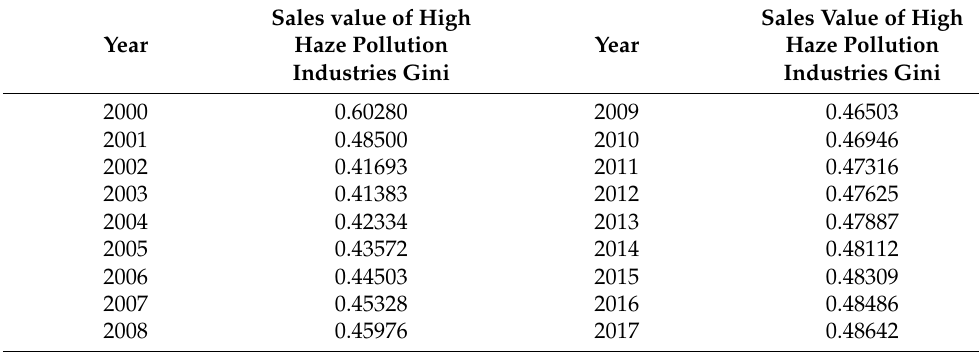
Table 2. Gini coefficient table of high haze pollution industries in the Beijing-Tianjin-Hebei region from 2000 to